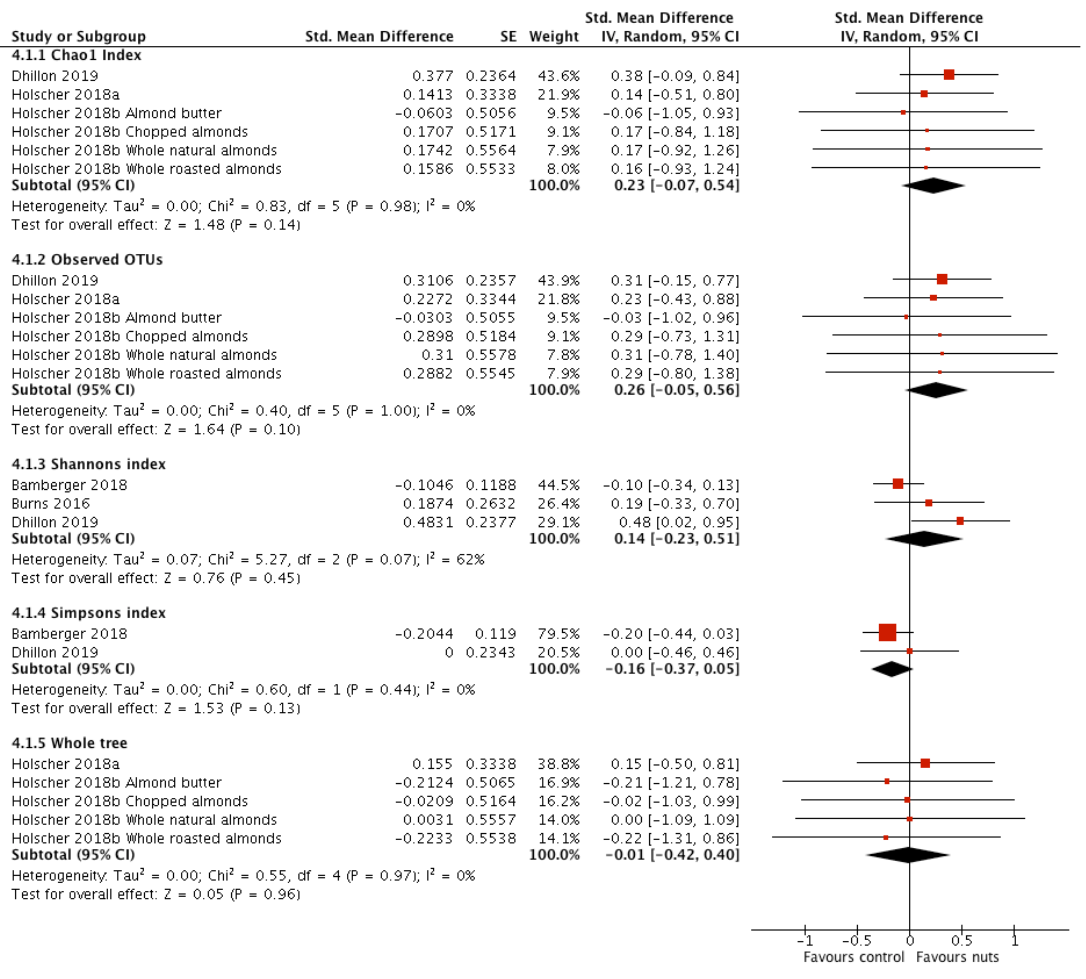
Figure 4. Forest plot of α -diversity metrics measured in faecal samples of participants taking part in randomised controlled trials comparing nut consumption to control in adults. Meta-analyses were conducted using a random effects model. Values are standardised mean difference (95% confidence interval).